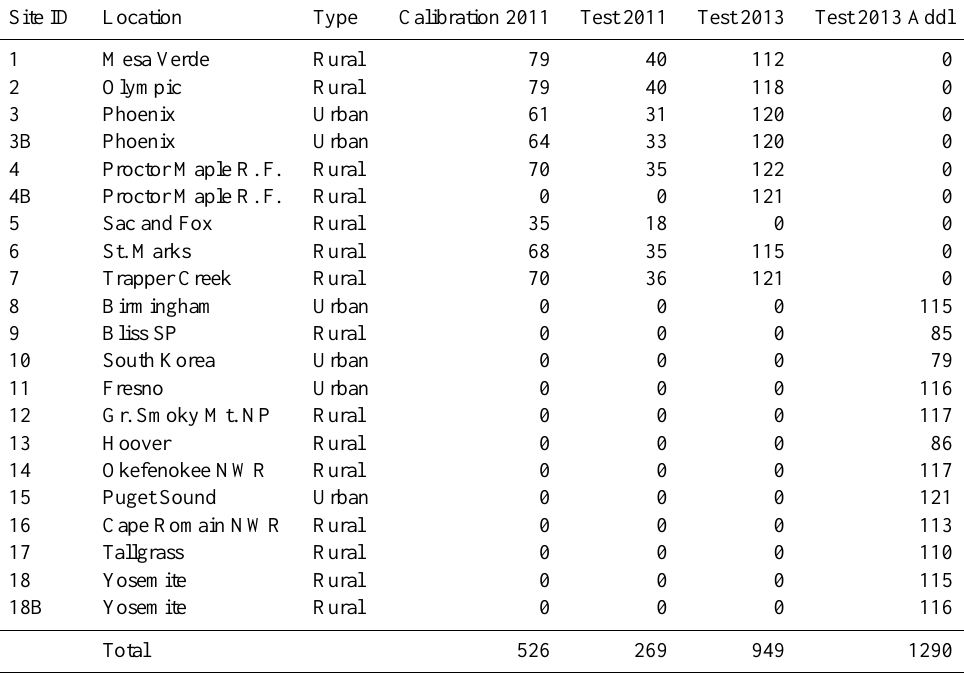
Table 1. IMPROVE network sites and number of samples in each data set described in Sect.